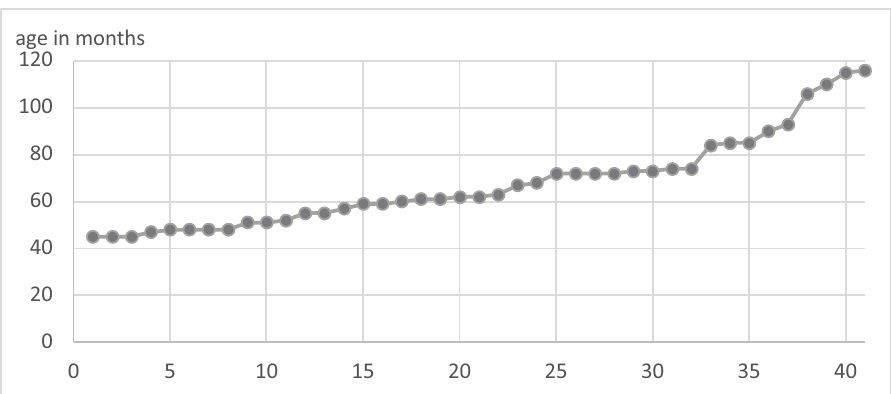
Figure 1: Distribution of the child participants per age (in